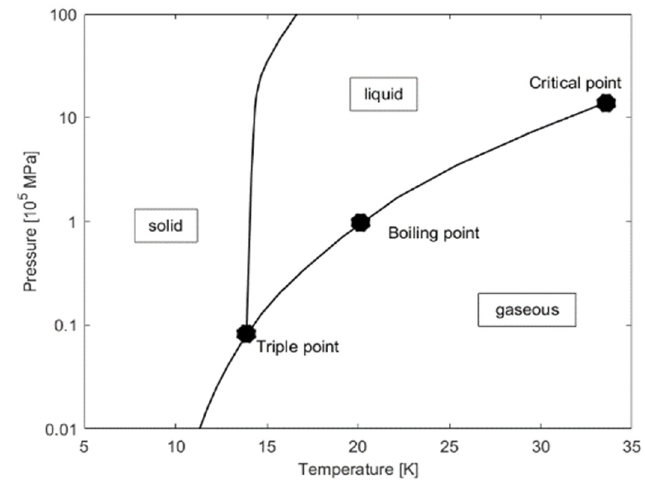
Figure 2. Phase diagram of hydrogen [21].